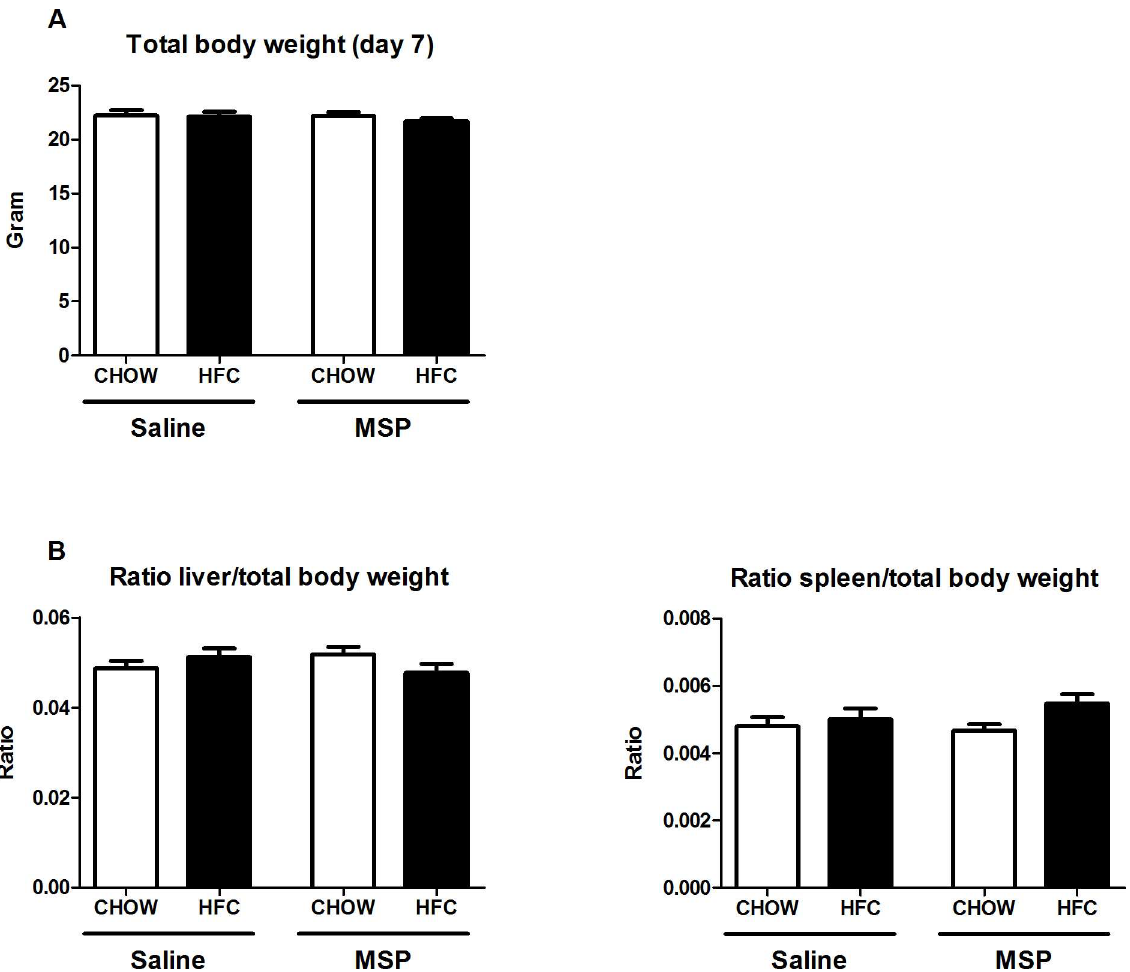
Fig 1. Relative liver and spleen weight. (A) Body weight after one week of regular chow or HFC diet in Ldlr -/- mice with and without MSP treatment. (B) Relative liver and spleen weights after one week of regular chow or HFC diet in Ldlr -/- mice with and without MSP treatment. Data are represented as mean ±